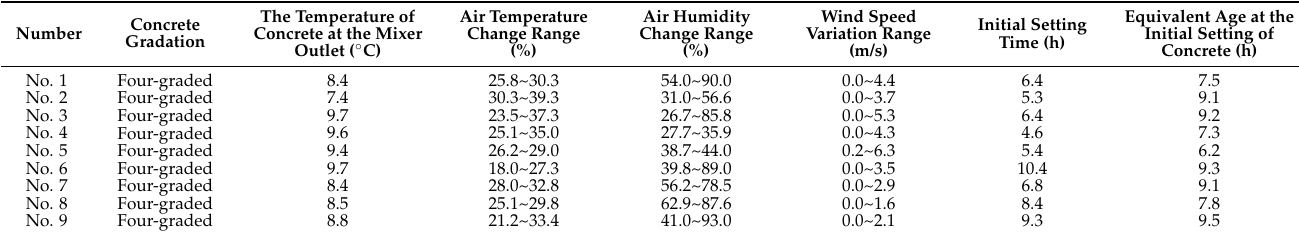
Table 6. Variation range of environmental variables on storehouse